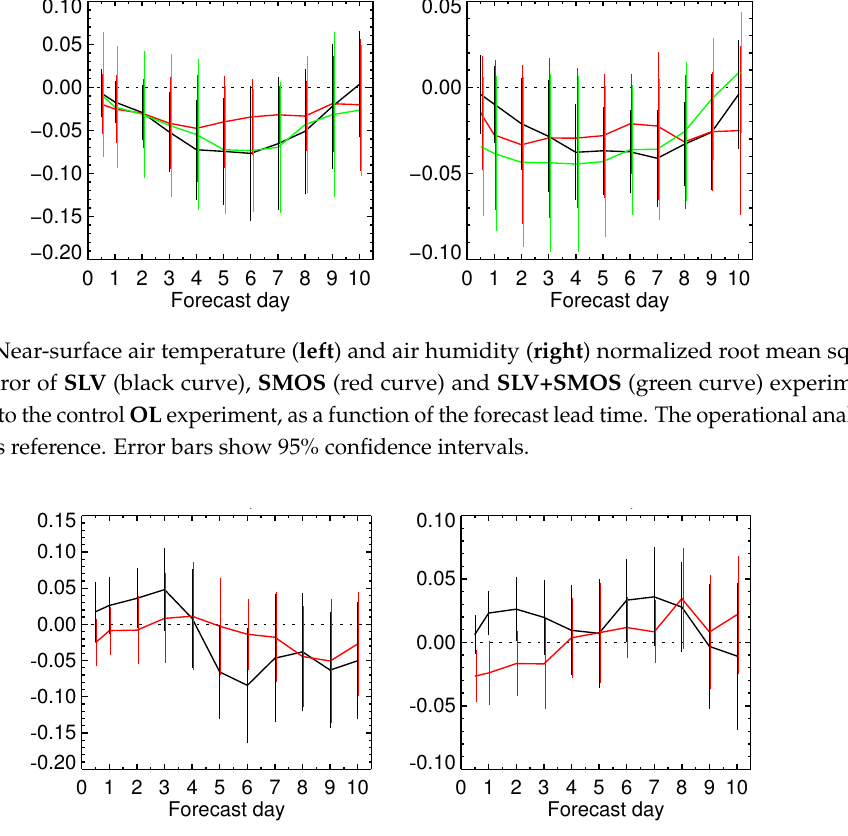
Figure 10. The same as Figure 9 but for the Group II of experiments; red curve is for SMOS+2R experiment and black curve for SMOS+PI experiment compared to the control SMOS